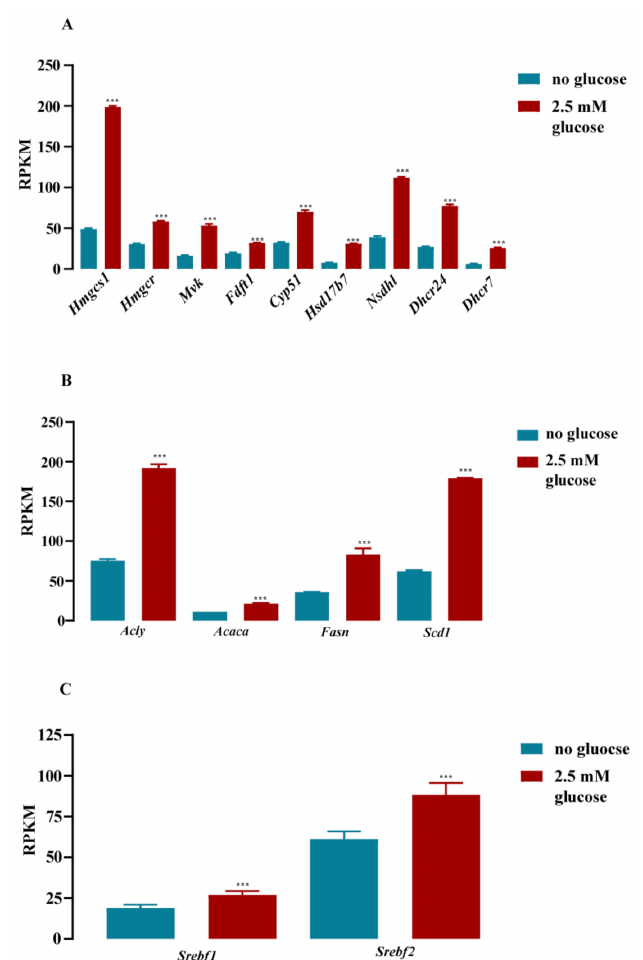
Figure 3. Glucose induced RNA expression of both Srebf genes and of key enzymes involved in cholesterol or fatty acid biosynthesis in mHypoA-2/10 cells. Cells were stimulated according to protocol 1 illustrated in Section 2.5 and RPKM determined by RNA-seq. For each condition, triplicates from one single experiment were analyzed as described under experimental procedures. In ( A ), data for 3-hydroxy-3-methylglutaryl-CoA synthase 1 (Hmgcs1), 3-hydroxy-3-methylglutaryl-CoA reductase (Hmgcr), mevalonate kinase (Mvk), farnesyl-diphosphate farnesyltransferase-1 (Fdft1), lanosterol 14 α -demethylase (Cyp51), hydroxysteroid 17- β dehydrogenase-7 (Hsd17b7), NAD(P)- dependent steroid dehydrogenase-like (Nsdhl), 24-dehydrocholesterol reductase (Dhcr24), and 7- dehydrocholesterol reductase (Dhcr7) are shown. In ( B ), data for the ATP citrate lyase (Acly), acetly-Coa carboxylase- α (Acaca), fattay acid synthase (Fasn), and stearoyl-Coa desaturase (Scd1) are presented. In ( C ), data for the sterol regulatory element-binding protein gene-1 (Srebf1) and -2 (Srebf2) are presented. Data are expressed as the mean ± S.E.M. of one single experiment (N = 1) performed in triplicate. Asterisks indicate significant differences calculated on the basis of Bonferroni-corrected p -values of the entire data set obtained by RNA-seq. *** p <